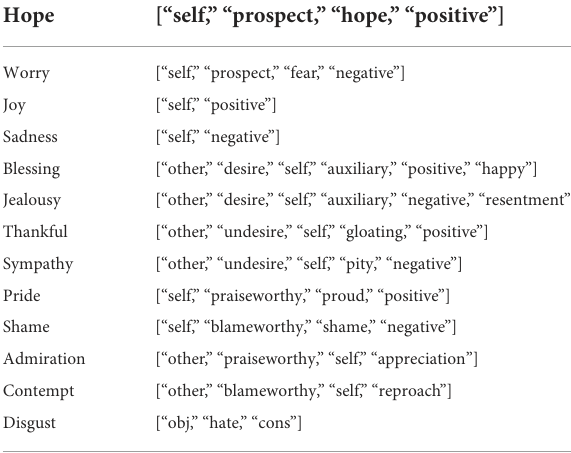
TABLE 4 Key tags sequence of 12 emotion types.